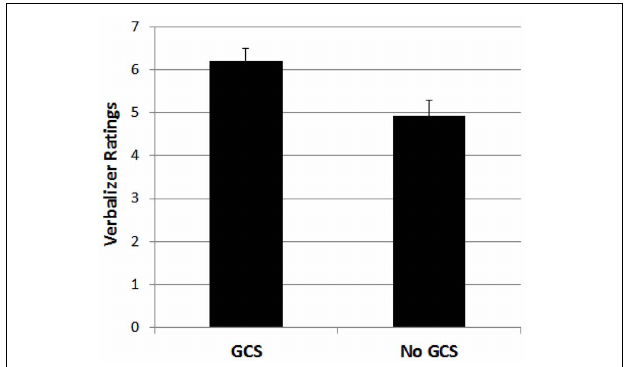
FIGURE 1 | Mean ratings for participants with grapheme-color synaesthesia (GCS) and without grapheme-color synaesthesia (No GCS) on the verbal style dimension. Error bars represent standard errors.